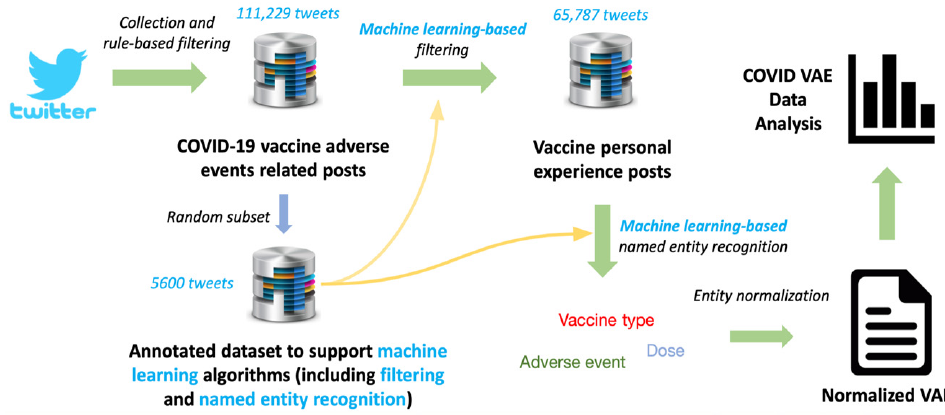
Figure 1. Method